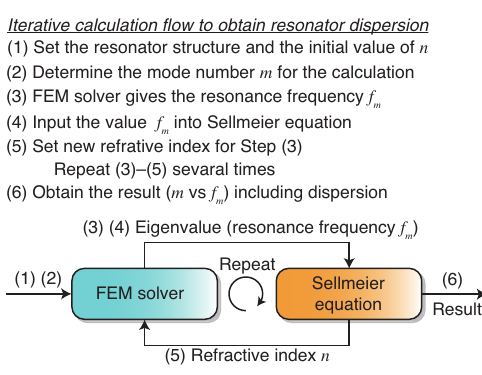
Figure 5: Iterative calculation flow for resonator dispersion taking account of material and geometry